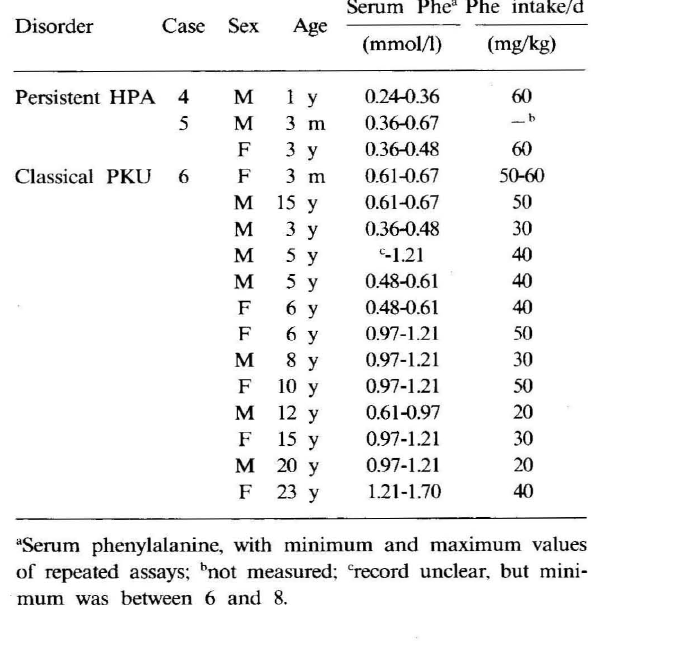
Table 2. Urinary neopterin (N), biopterin (B), and NIB levels